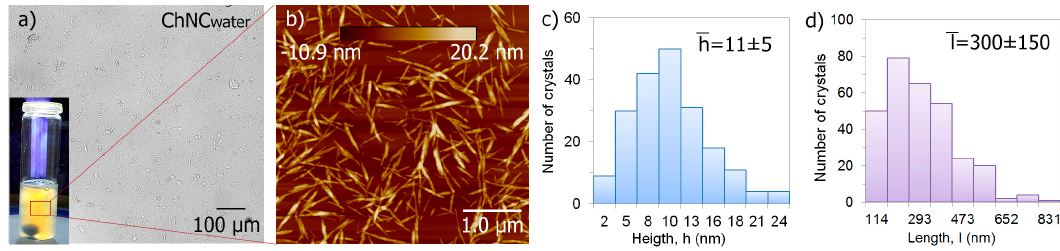
Figure 1. ChNC characteristics: ( a ) an optical microscopy image and a photograph displaying flow birefringence of the aqueous ChNC suspension; ( b ) a height AFM image showing the shape of ChNC; ( c , d ) diameter (height) and length distributions indicating the average width (h) and average length (l).